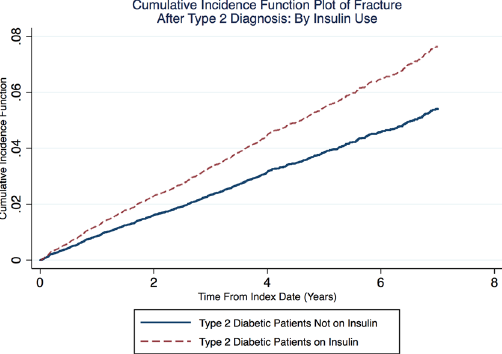
Figure 1. Cumulative incidence function plot of bone fracture after type 2 diabetes mellitus diagnosis between non-insulin and insulin users accounting for time-varying